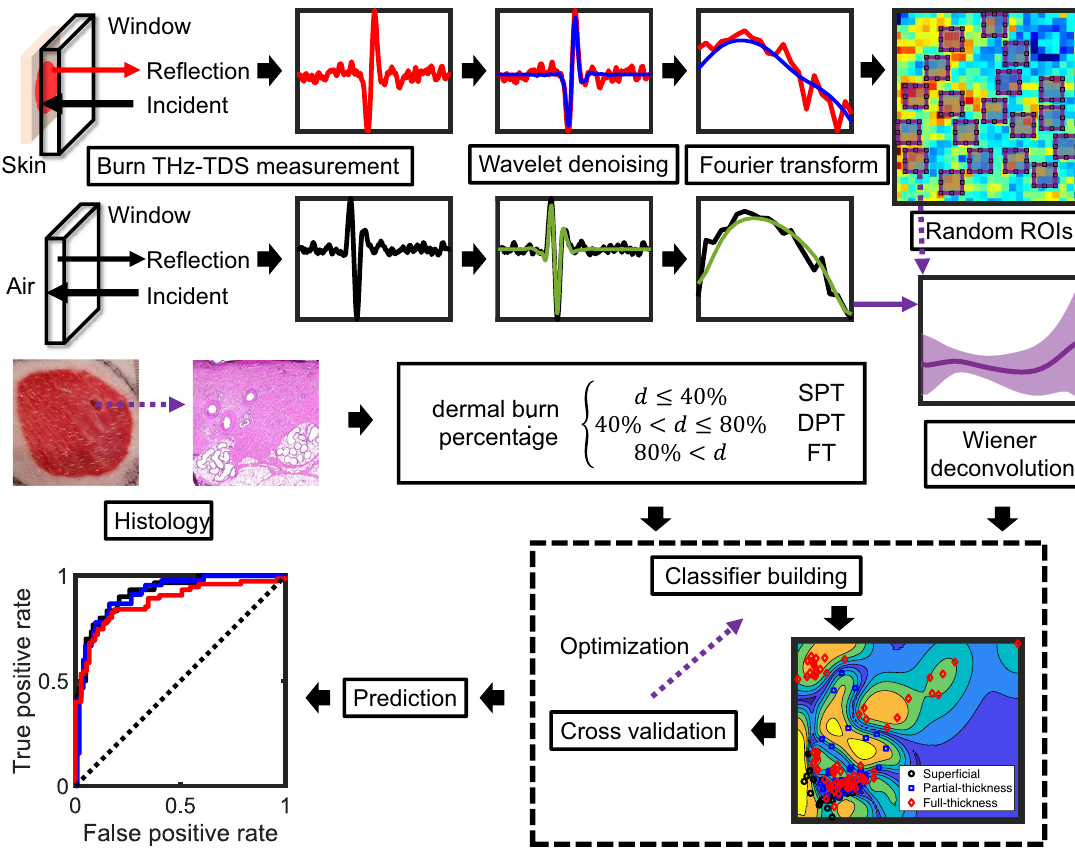
Figure 3. The workflow of training and testing the classifiers for diagnosing a burn injury’s severity into one of the SPT, DPT, and FT groups. After wavelet denoising and Wiener deconvolution of the measured THz pulses, an image was formed using the bandwidth-limited area under the reflection spectral amplitude curve. Fifteen 4 × 4-pixel regions of interest (ROI) were selected randomly over each image. The burn severity labels were assigned using the dermal burn percentage ( d ) in biopsies collected on Day 4 (SPT ( d < 40% ), DPT ( 40% < d < 80% ), and FT ( 80% > d )). Each classifier’s specific hyper-parameters were optimized using Bayesian optimization during training. Additionally, to avoid over-fitting, each classifier was fivefold cross validated. The performance of various machine learning techniques (i.e., SVM, NB, LDA, and boosted LDA) was evaluated based on the area under the receiver operating characteristic (ROC)